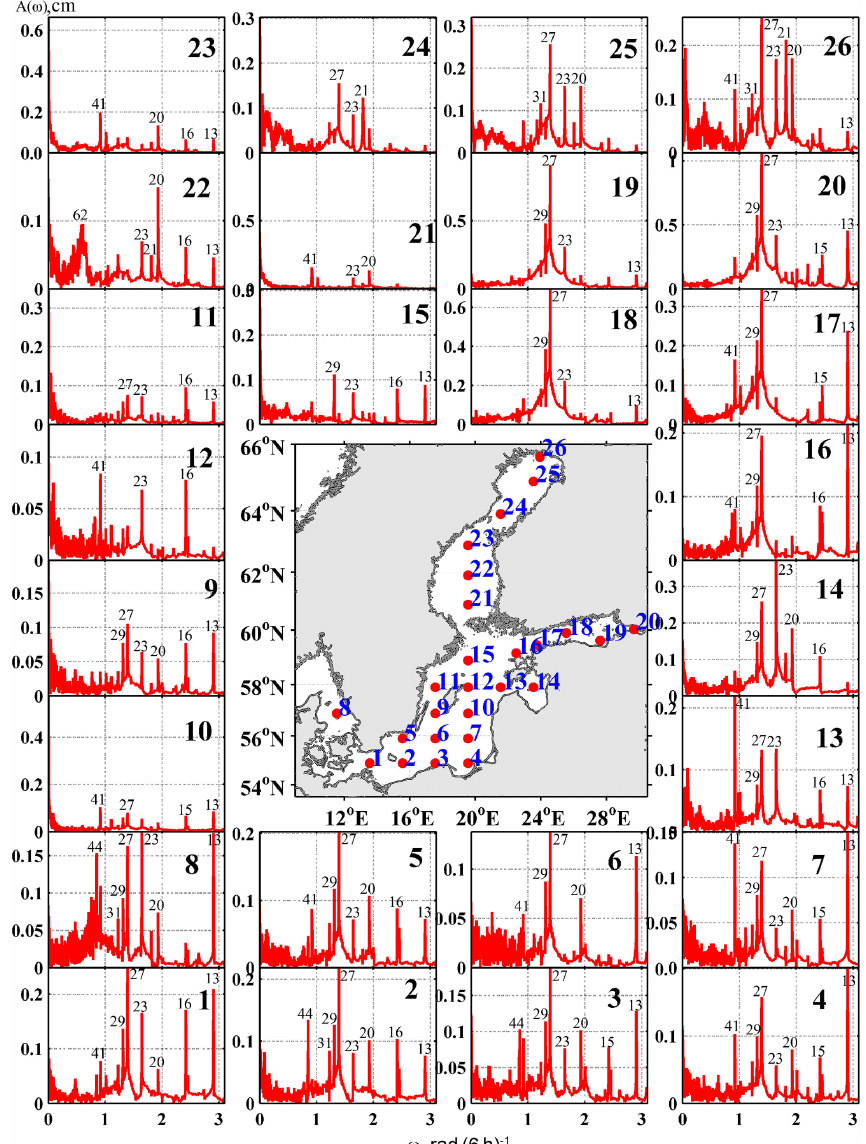
Figure 6. Amplitude spectra A(ω) of free barotropic oscillations in different parts of the Baltic Sea. Numbers above the peaks show oscillation periods in hours. Locations of points are shown on the